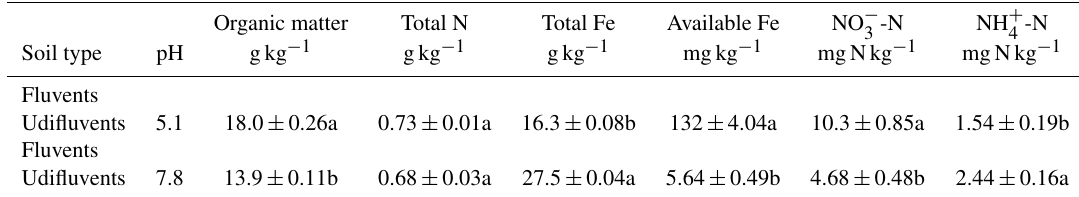
Table 1. Chemical properties of the soils with low pH and high pH. Different letters represent statistically significant differences between treatments at P <0.05.